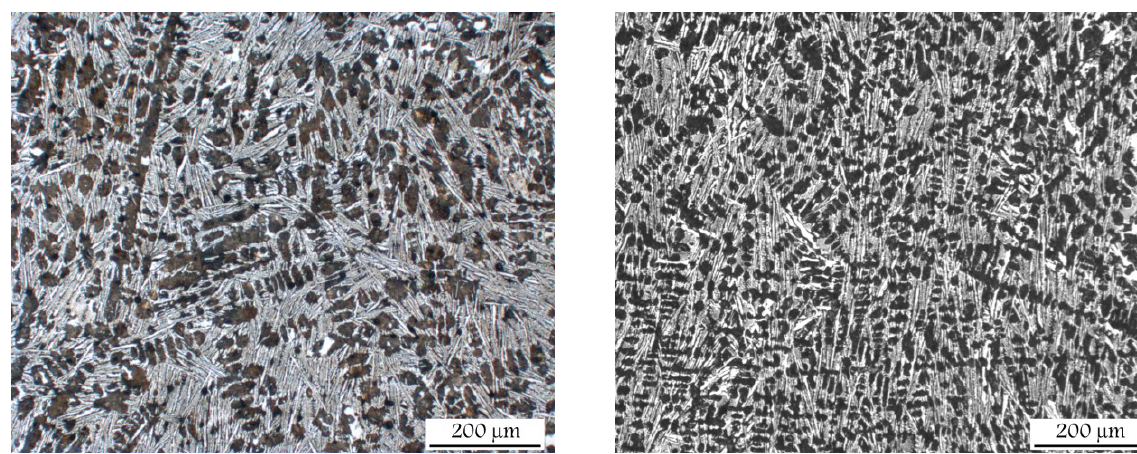
Figure 6. Coarser structure of A alloy in non-inoculated sample ( left ); compared to the inoculated one ( right ) for similar solid fraction (0.53 and 0.49